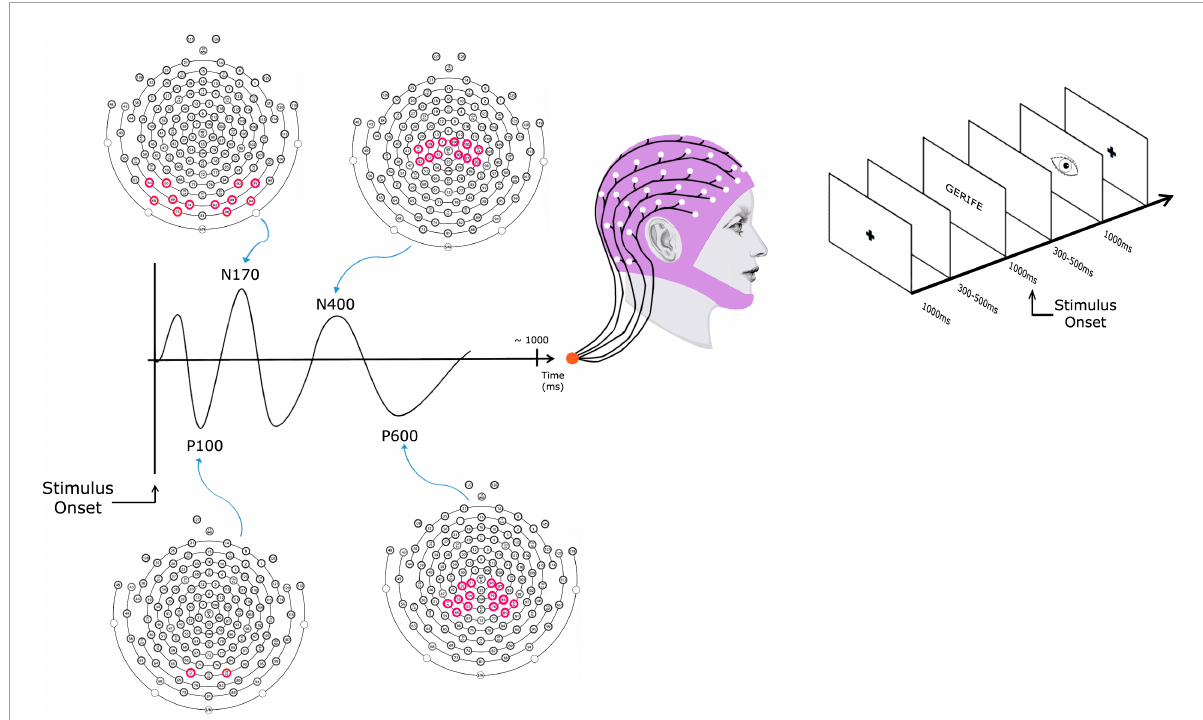
FIGURE1 A schematic presenting the event-related potential (ERP) to lexical decision task stimulus obtained by averaging the electroencephalography (EEG) signal of multiple stimulus presentations. The data was collected with a 128-channel array of scalp electrodes from which the EEG was recorded. The electrodes chosen for the four components were: P100 (Occipital), N170 (Occipital-Temporal), N400 (Central), and P600 (Central-Parietal). In the electrode’s figures, the purple circles indicate which electrodes were used for each